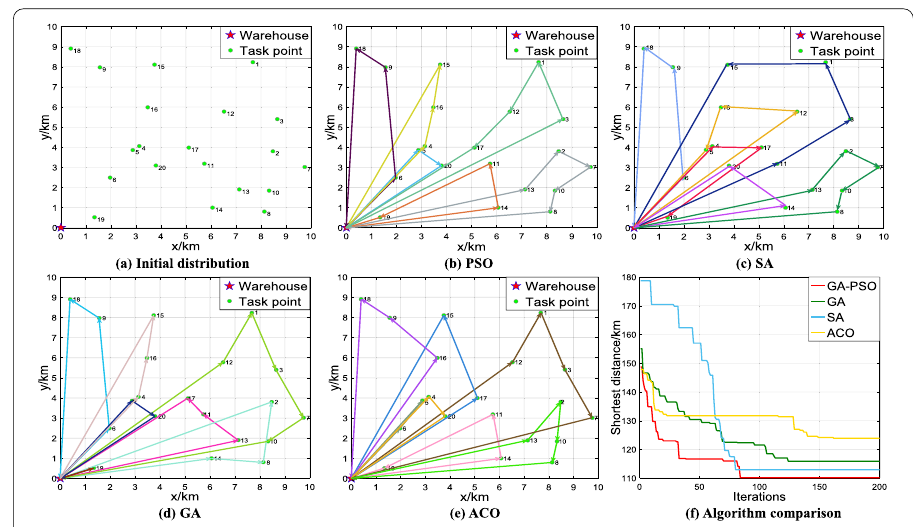
Fig. 6 The results of the second group of the experimental optimal solutions of task allocation